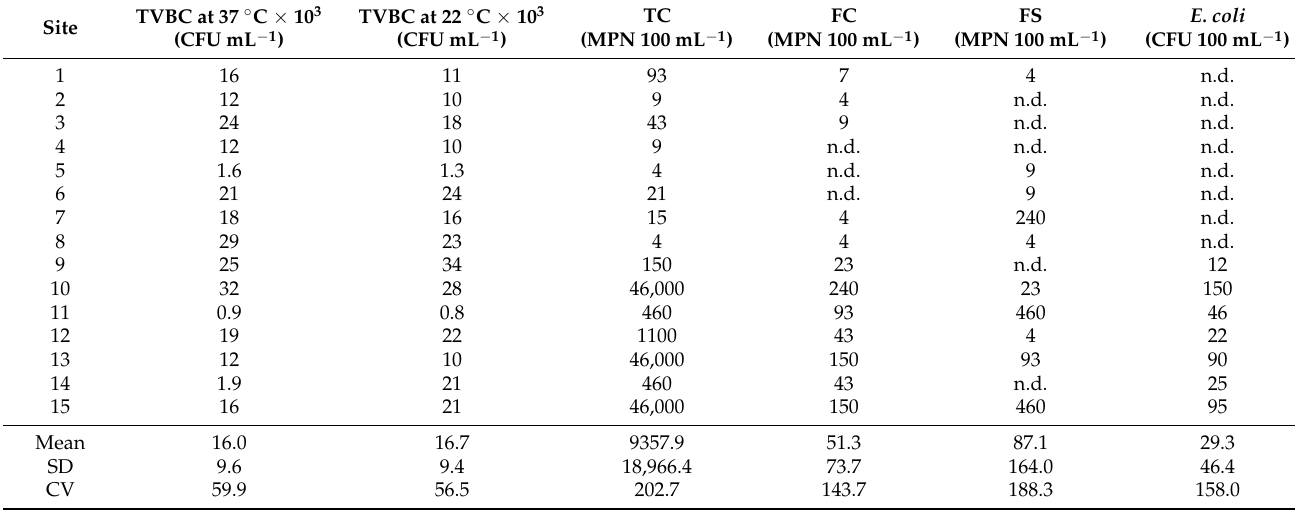
Table 4. Bacterial assessment of the main channel of Lake Nasser before flooding (the pre-flood period).